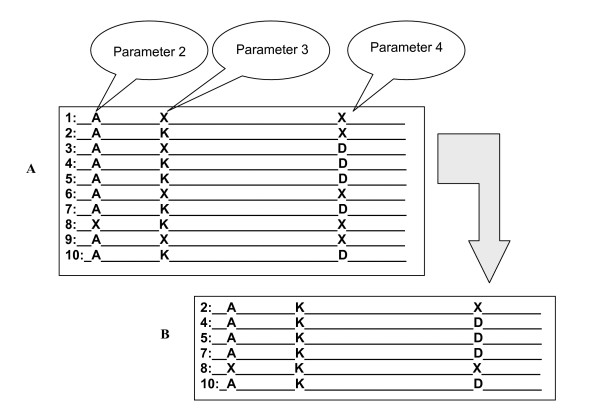
Schematic representation of the correlated mutations algorithm. The letter X stands for any residue not identical to the dominant residue in the corresponding position. The panel "A" illustrates multiple sequence alignment (MSA) and panel "B" shows sub-multiple sequence alignment (sMSA). The sMSA is obtained by selecting all sequence of the MSA having Lys residue at the position marked as Parameter 3.